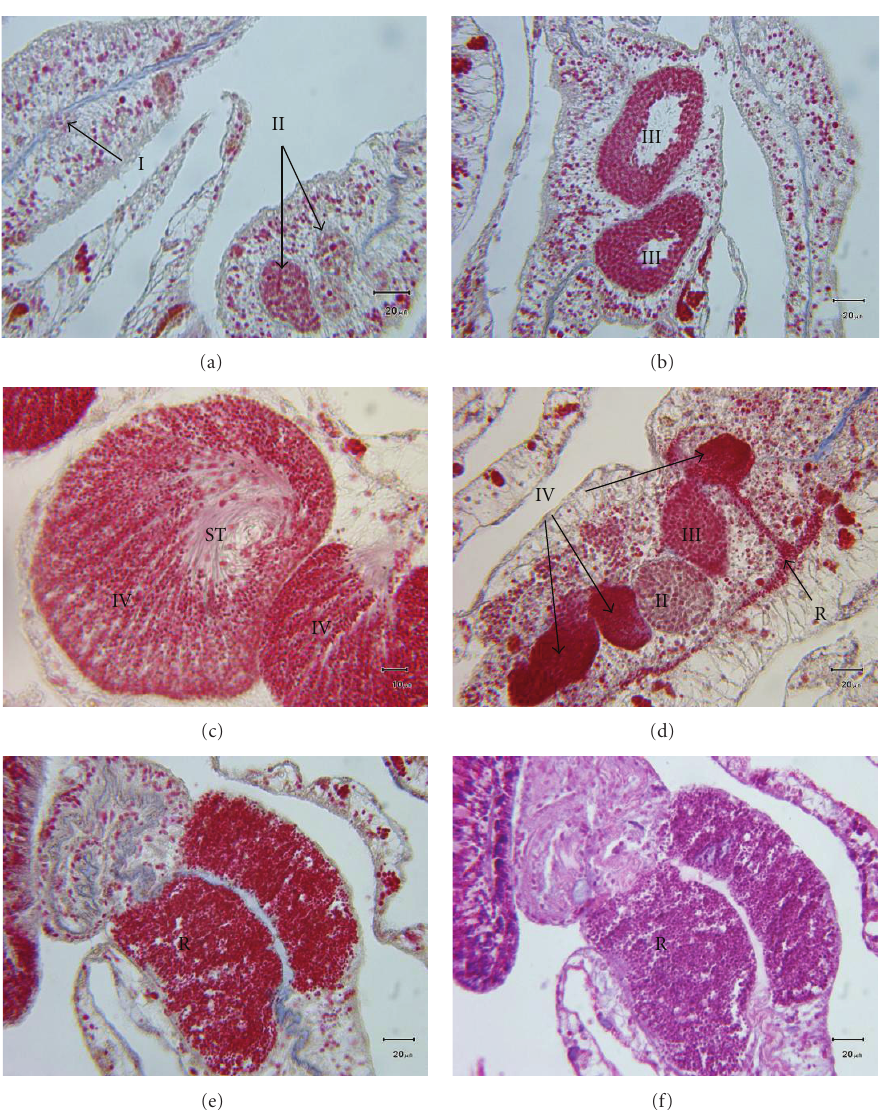
Figure 4: Photomicrographs of Solenastrea bournoni spermary stages I–IV (defined by Table 1). (a) Stages I and II spermaries; (b) stage III spermaries; (c) stage IV spermaries, ST = spermatozoa tails lined up; (d) stages II, III, and IV, R = spermatozoa being released into gastrovascular cavity; (e) released spermatozoa (R) stained with Heidenhain’s azocarmine aniline blue; (f) released spermatozoa (R) stained with H&E. All scale bars 20 μ m except for (c) which is 10 μ